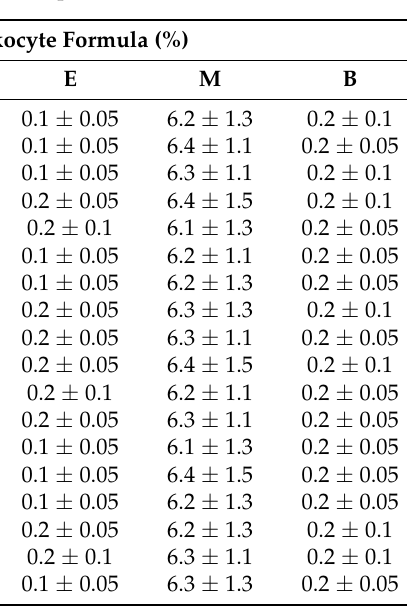
Table 5. Changes in the percentage values of the components in the leukocyte formula in animals that received electrospun samples. Values are expressed as arithmetic mean ± SD of the average percentage of components in the leukocyte formula for 5 mice per